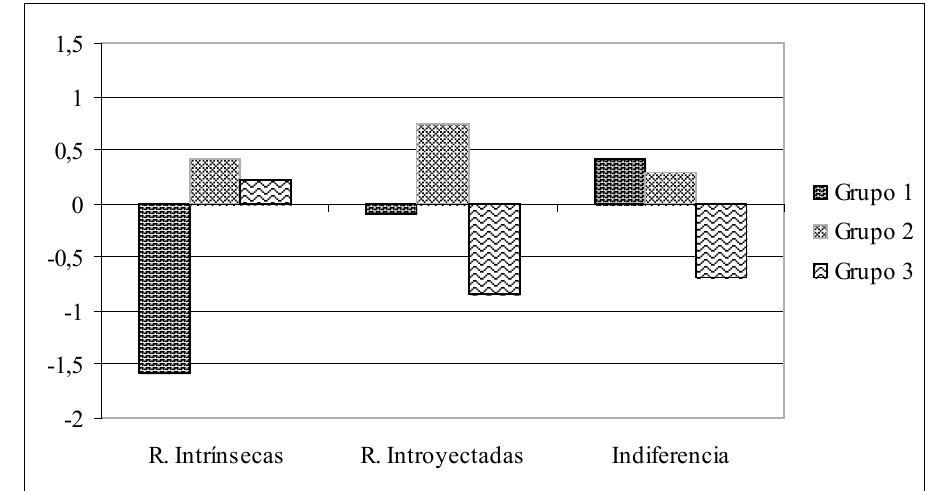
Figura 1 . Peso de las variables de las estrategias para la disciplina utilizadas por el profesor en los tres conglomerados. En el eje vertical aparecen las puntuaciones Z